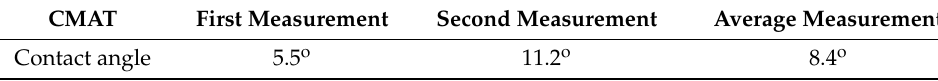
Figure 5. Water-contact-angle goniometer measurement of ( a ) CMAT 5.5° and ( b ) CMAT 11.2°. Time of the measurement: (date: 26 November 2022 at 15:23). Table 1. The CMAT’s contact angle was gauged using a measurement. CMAT First Measurement Second Measurement Average Measurement Contact